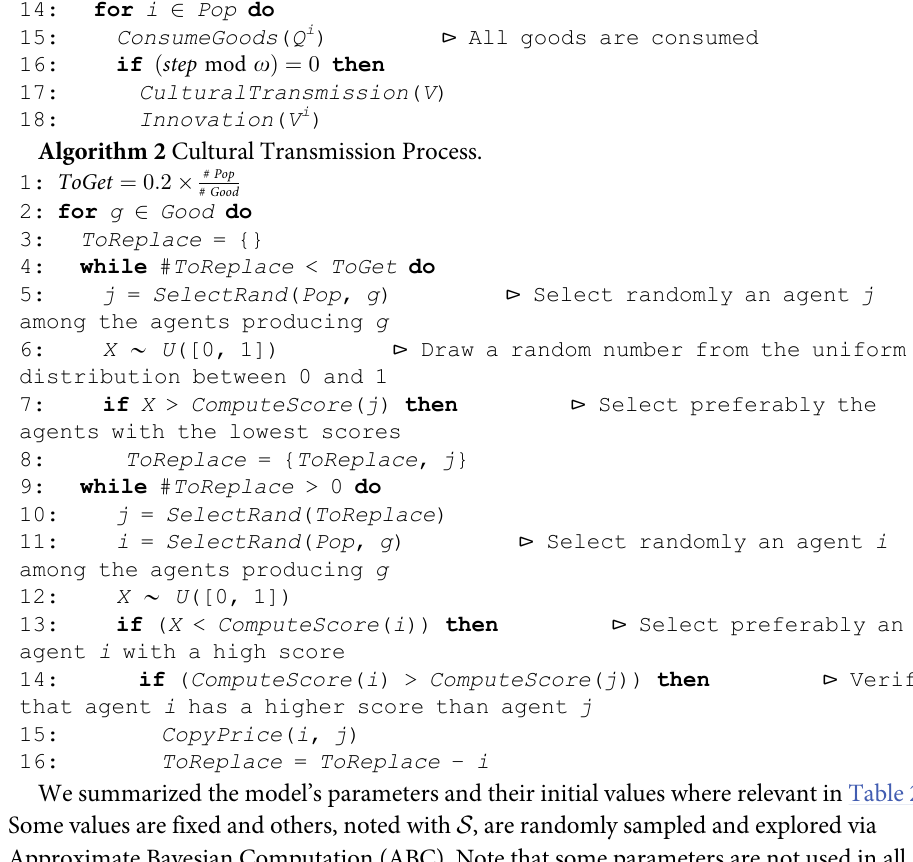
Algorithm 2 Cultural Transmission